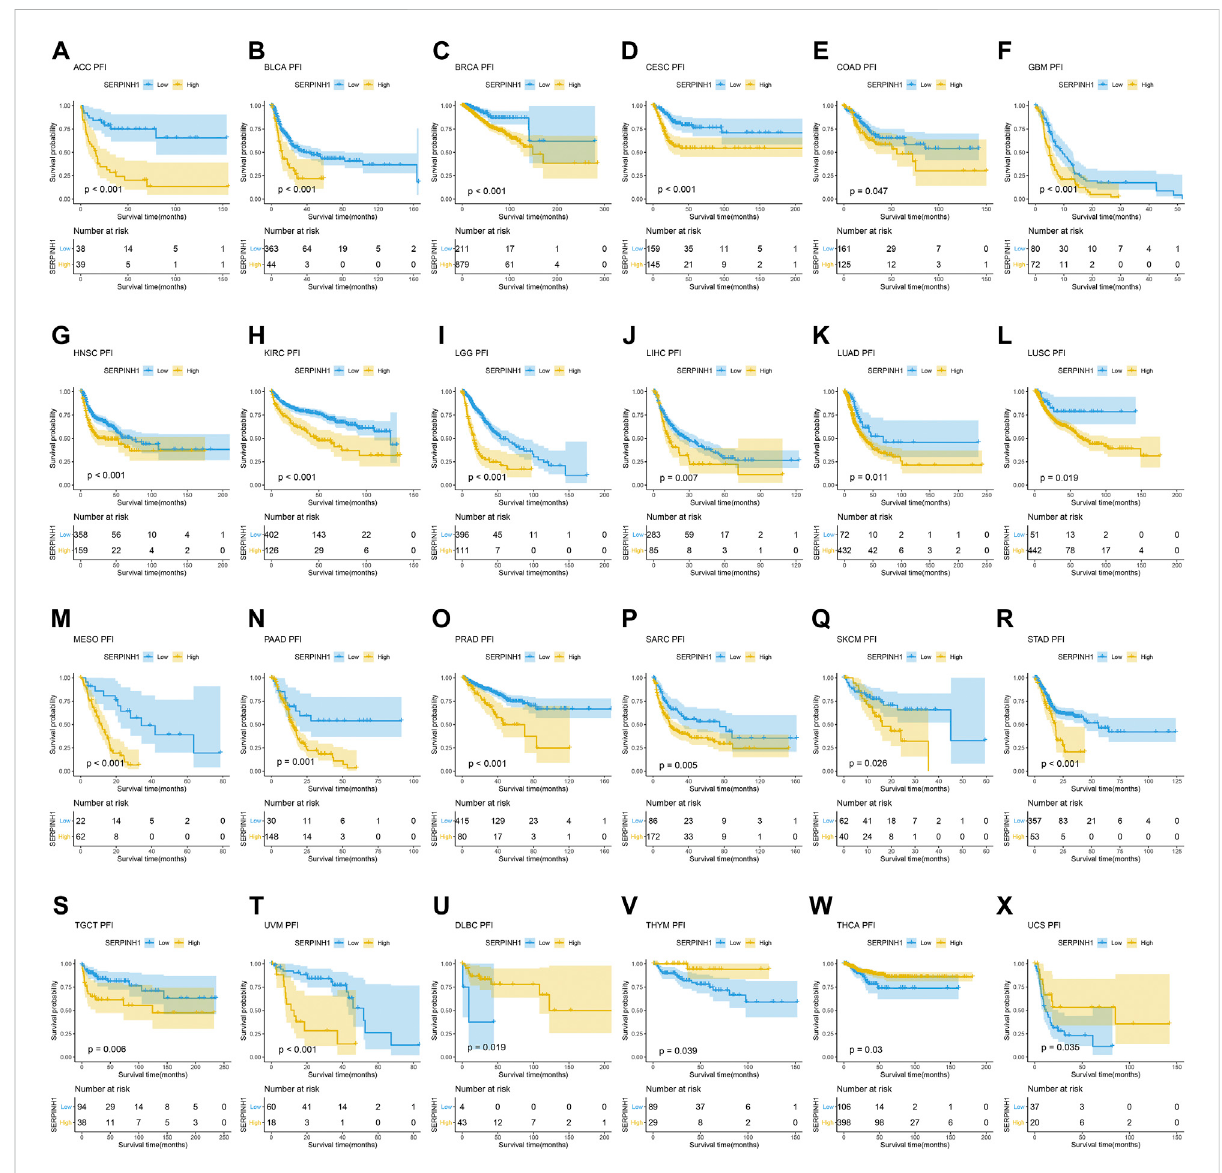
FIGURE 7 Kaplan – Meierrelapse-freesurvival(PFI)analysis. (A – T) HighexpressionofSERPINH1isrelatedtopoorPFI; (U – X) lowexpressionofSERPINH1is related to poor